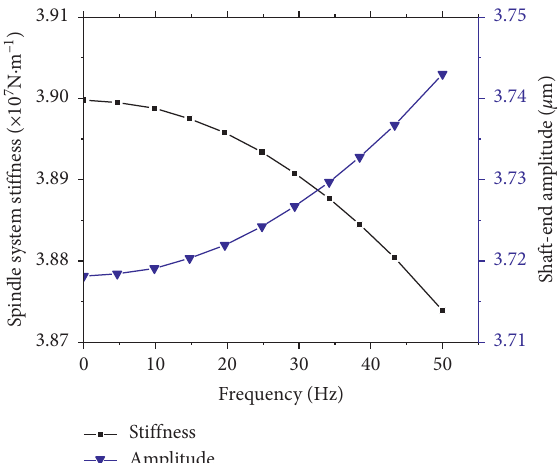
Figure 2: Stiffness and amplitude of the spindle system under different excitation frequencies.